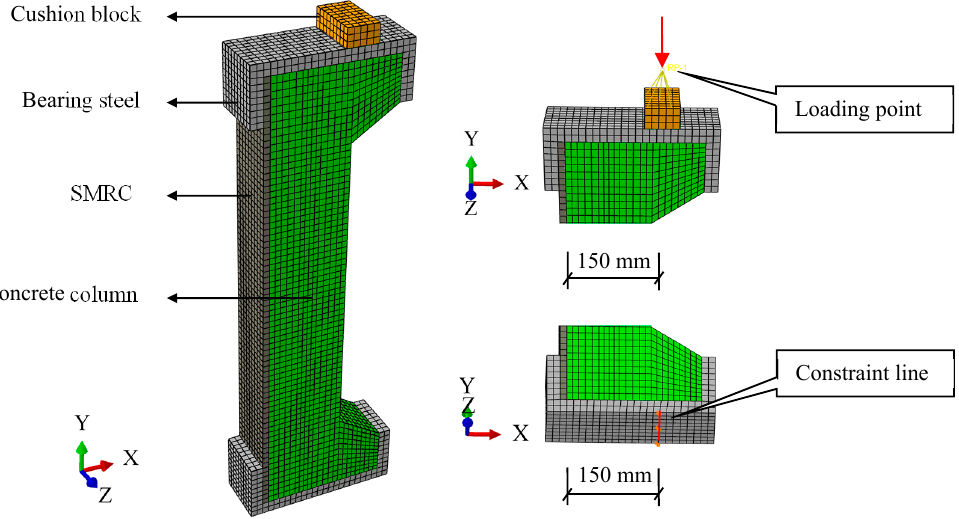
Figure 15. Finite element model and boundary condition. SMRC indicates steel mesh reinforced resin concrete.